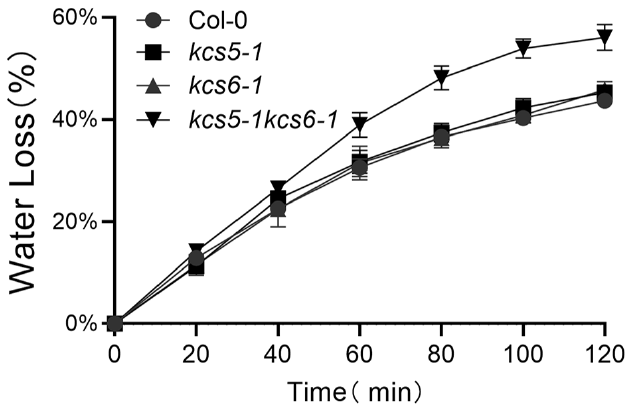
Figure 5. Water loss assay of detached leaves. Excised leaves’ water loss rates were recorded over 120 min and measured as a percentage of the initial weight of fully hydrated leaves. Values are the mean of five replicate assays. Error bar = SD. The experiments were repeated once with similar